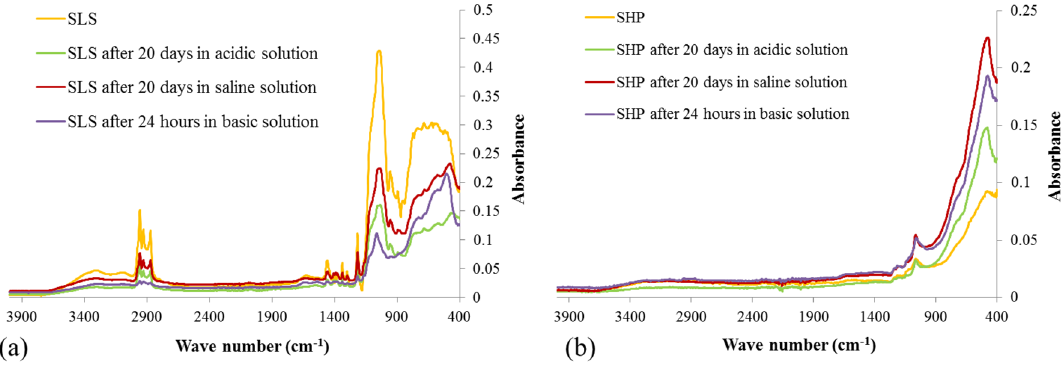
Figure 9. FT-IR of SLS ( a ) and SHP ( b ) surfaces after aging in harsh environment .